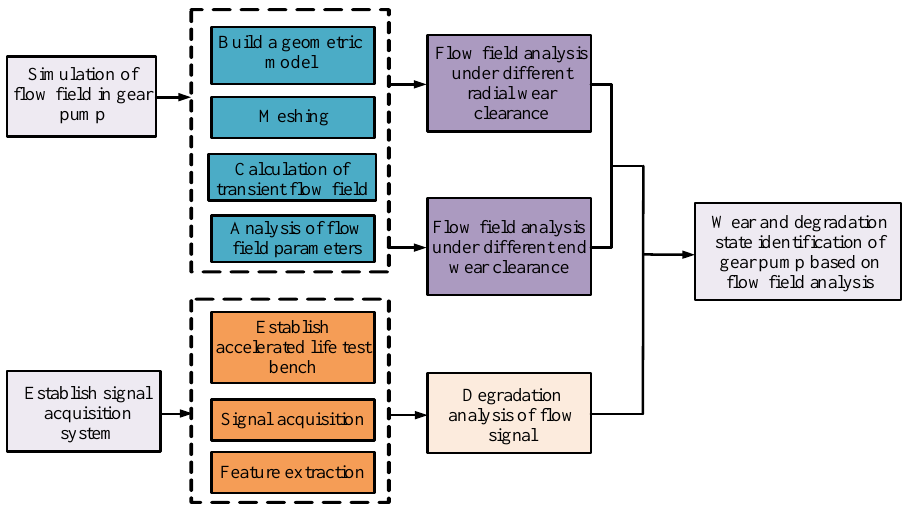
Figure 1. Flow chart of technical route.